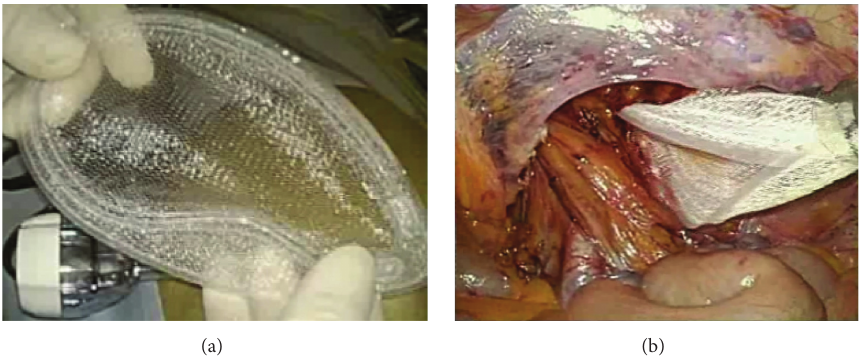
Figure 1: Polysoft mesh with the memory-ring (a). The mesh can be inserted into the abdominal cavity via a 12mm port. Turning down the mesh in a dog-ear fashion using the interruption of the memory-ring